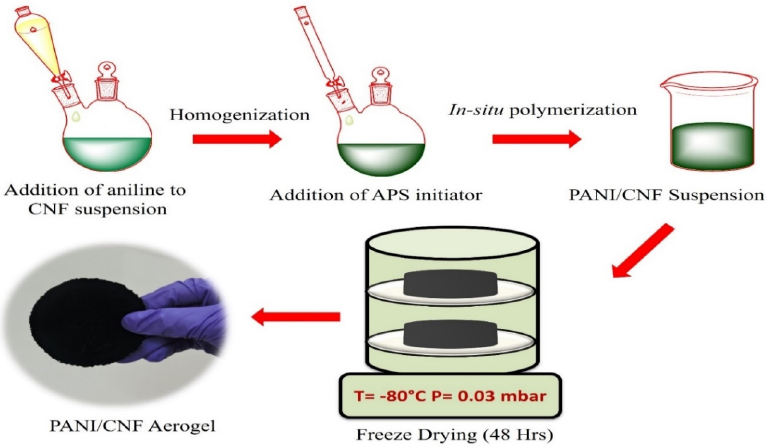
Figure 17. A demonstration of various steps involved in the fabrication of PANI/CNF aerogels. Reproduced with permission from [157]. Copyright 2020, Elsevier Ltd.